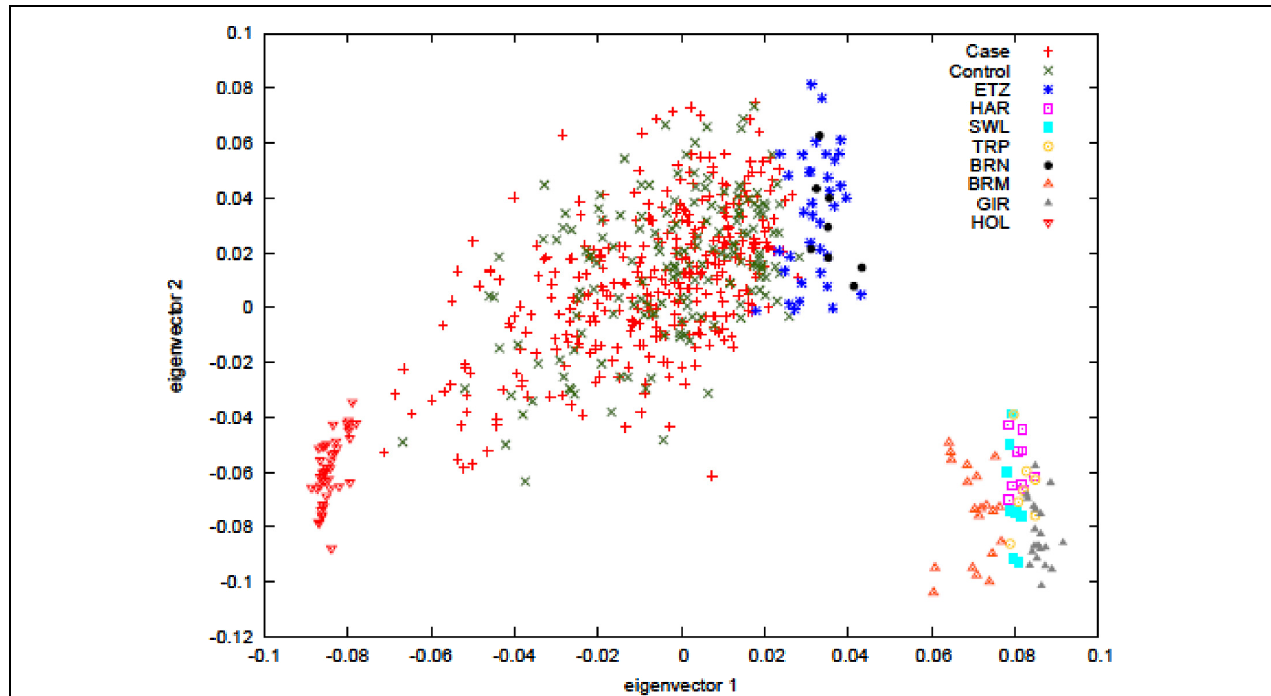
FIGURE 1 | Principal component analysis of hybrids cases (reactors) and hybrids controls (non-reactors). The analysis includes the ancestral populations of European Bos taurus (Holstein, HOL), East African zebu (Ethiopian zebu – ETZ and Boran – BRN), and non-African zebu (Hariana – HAR, Sahiwal – SWL, Tharparker – TRP, Brahman – BRM, Gir – GIR).